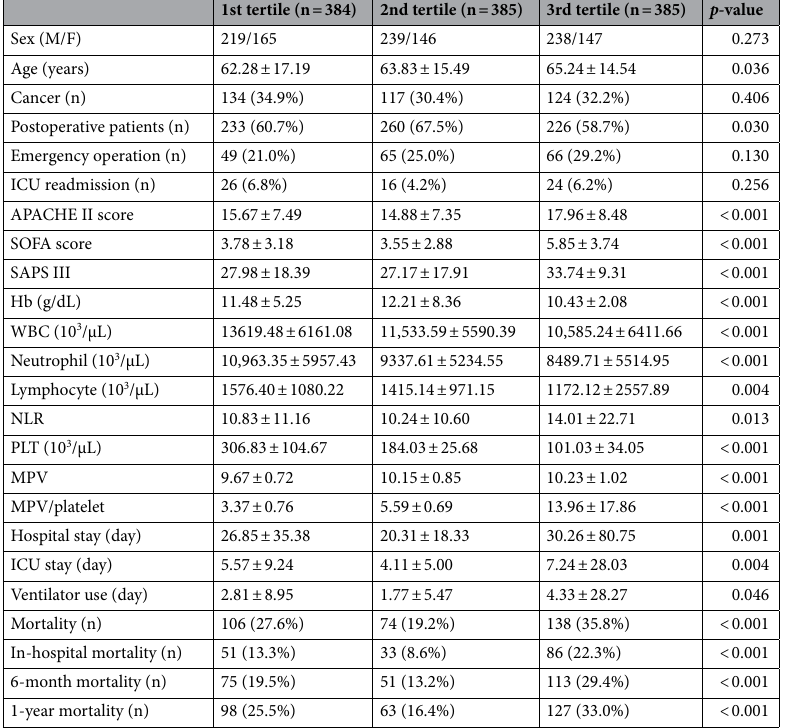
Table 3. Baseline characteristics and outcome variables across MPV/platelet ratio tertiles. Values are presented as the mean ± standard deviation or number of patients (%). ICU, intensive care unit; APACHE II, Acute Physiology and Chronic Health Evaluation; SOFA, Sequential Organ Failure Assessment; SAPS III, Simplified Acute Physiology Score; Hb, haemoglobin; WBC, white blood cell; NLR, neutrophil to lymphocyte ratio; PLT, platelet; MPV, mean platelet